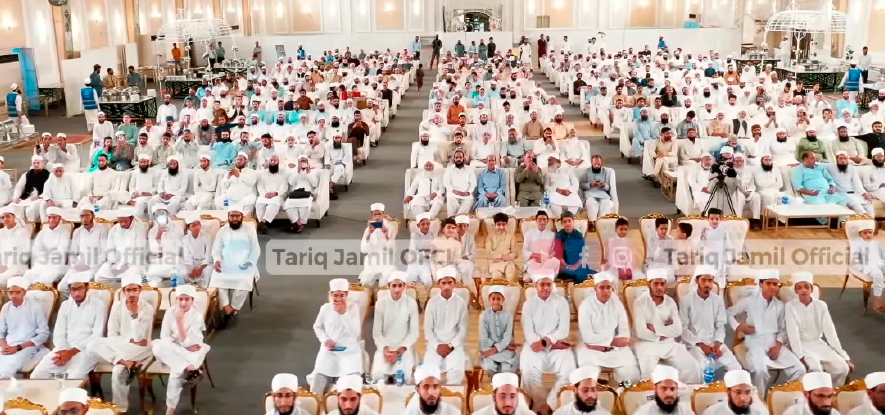
Figure 8. Students listening attentively to Maulana Tariq Jamil at the annual graduation ceremony of Jamia al-Hasanain in June 2022. Source: https://www.youtube.com/watch?v=FL1HGay20Rs&t=962s. A Shift from ‘Hard’ to ‘Soft’ Tabligh